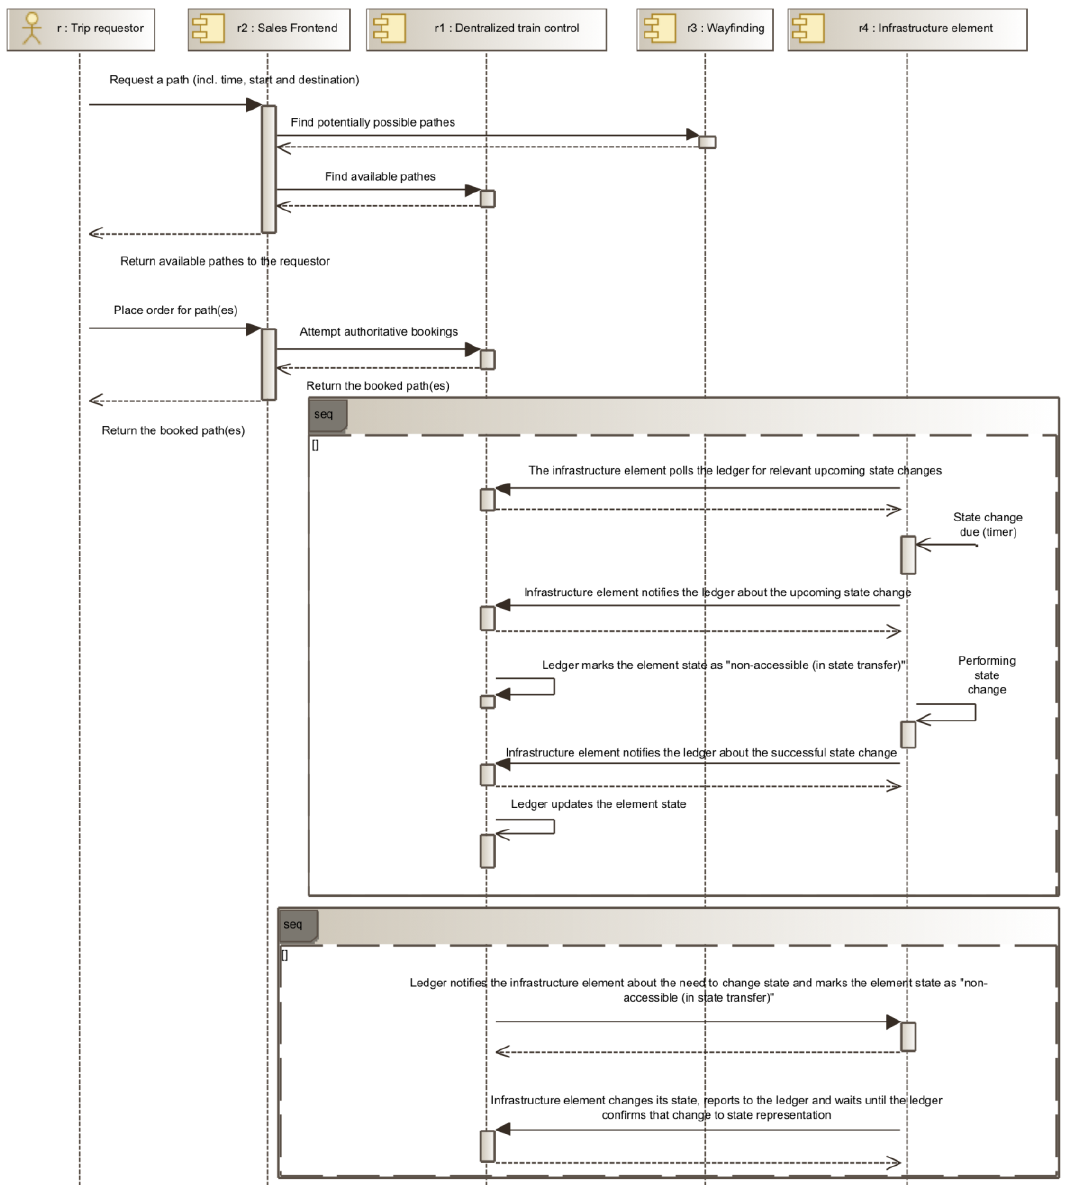
Fig. 4. Sequence diagram of the path reservation logic (excerpt, simplified